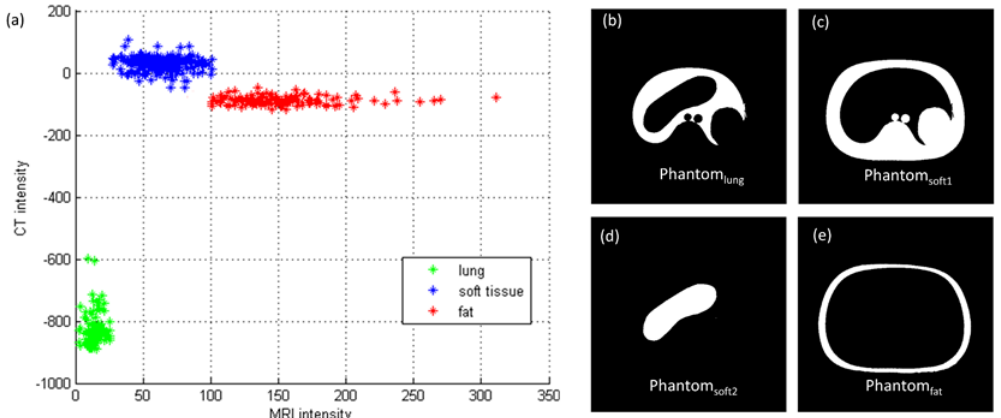
Figure 4. ( a ) Pointwise intensity pairs and phantom image segmented into ( b ) lung, ( c ) low-intensity soft tissue, ( d ) high-intensity soft tissue, and ( e ) fat.